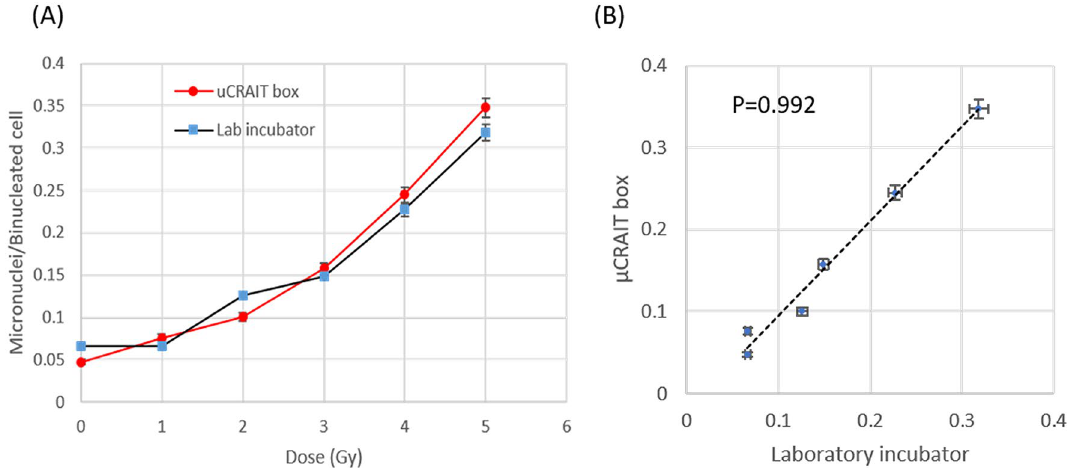
Figure 5. ( A ) Dose curves of CBMN assays generated by cell cultures inside a µCRAIT box during transportation and a laboratory CO 2 incubator; both show clearly dose response; ( B ) dose responses from µCRAIT box and the control laboratory incubator have a high linear correlation with a Pearson’s correlation coefficient of 0.992; a linear trendline is also